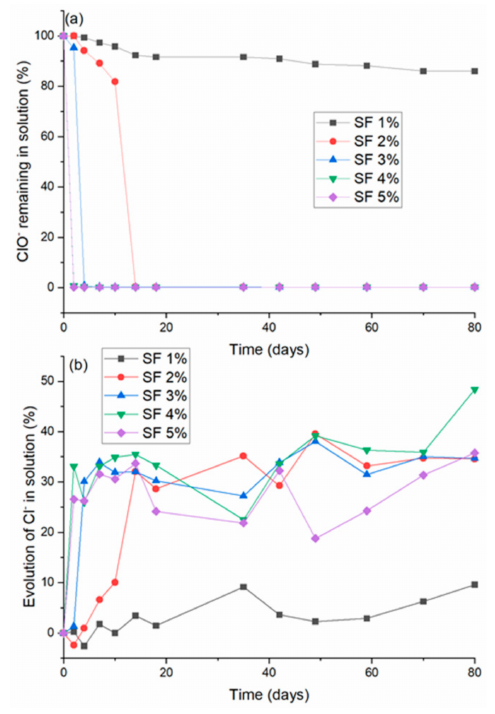
Figure 9. Time evolution of ( a ) the normalized concentration of hypochlorite ions and ( b ) the percentage increase in chloride ions in CBR decontaminating solutions with 1–5 wt.%